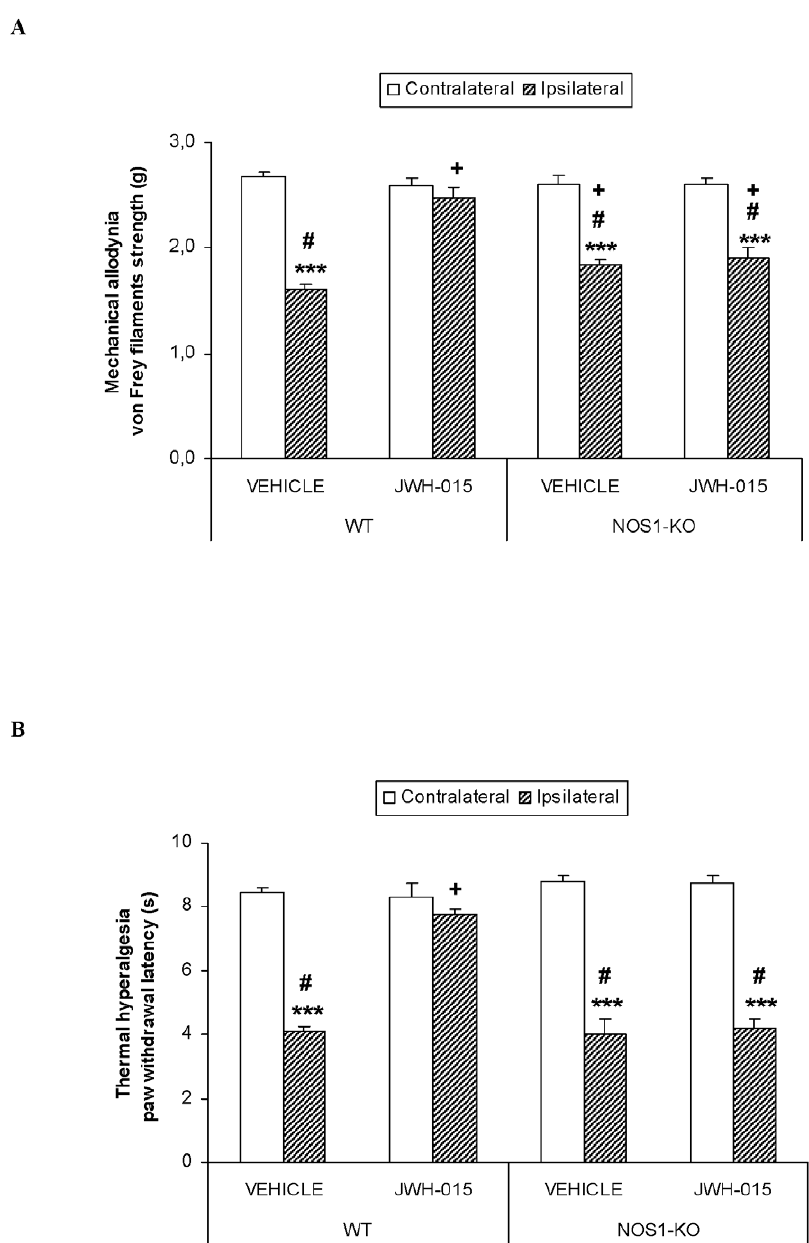
Figure 5. The antiallodynic and antihyperalgesic effects of JWH-015 in WT and NOS1-KO mice. Effects of the subplantar administration of 150 m g of JWH-015 or vehicle in the contralateral and ipsilateral paw withdrawal latencies to a mechanical (A) or thermal (B) stimulus in WT and NOS1-KO mice, at 10 days after CFA injection. Data are expressed as mean values of the von Frey filaments strength (g) for mechanical allodynia and as the paw withdrawal latency (s) for thermal hyperalgesia 6 SEM (5–6 animals per group). For each test, *** p , 0.001, indicates significant differences vs. their contralateral paw (paired Student’s t test), + indicates significant differences as compared with the ipsilateral paw of vehicle treated group (p , 0.05, one way ANOVA followed by the Student-Newman-Keuls test) and # indicates significant differences as compared with the ipsilateral paw of WT group treated with JWH-015 (p , 0.05, one way ANOVA followed by the Student-Newman-Keuls test).